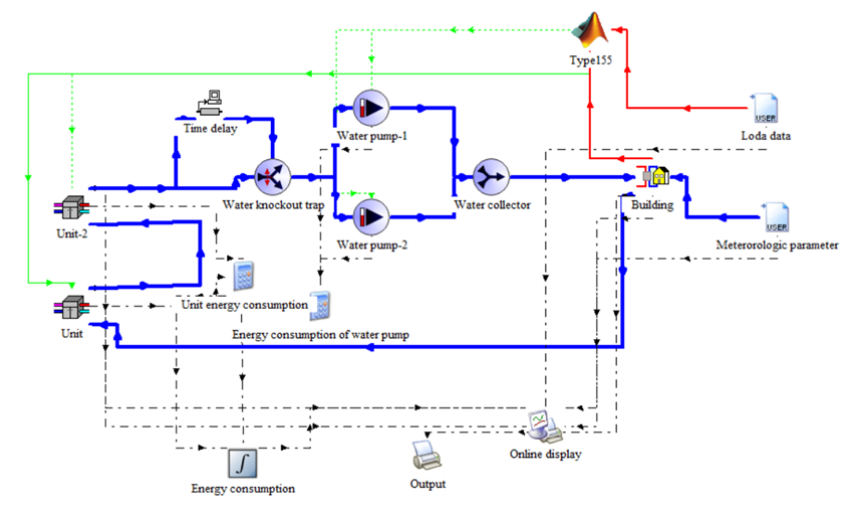
Figure 10. TRNSYS simulation platform of the LFF control strategy.